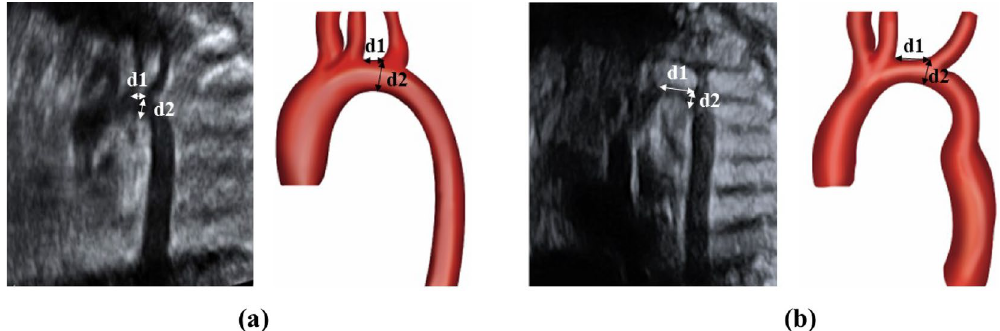
Figure 1. Echocardiographic and enhanced computed tomography scheme of an aortic arch (DA index = d1/ d2). Echocardiographic and enhanced computed tomography image of a normal aortic arch with normal DA index ( a ) and CoA with abnormal DA index ( b ). The DA index was the ratio of the distance between the origin of the left carotid artery and the origin of the left subclavian artery (d1) to the diameter of the distal aortic arch at the origin of the left subclavian artery (d2). DA distal aortic arch, CoA coarctation of the